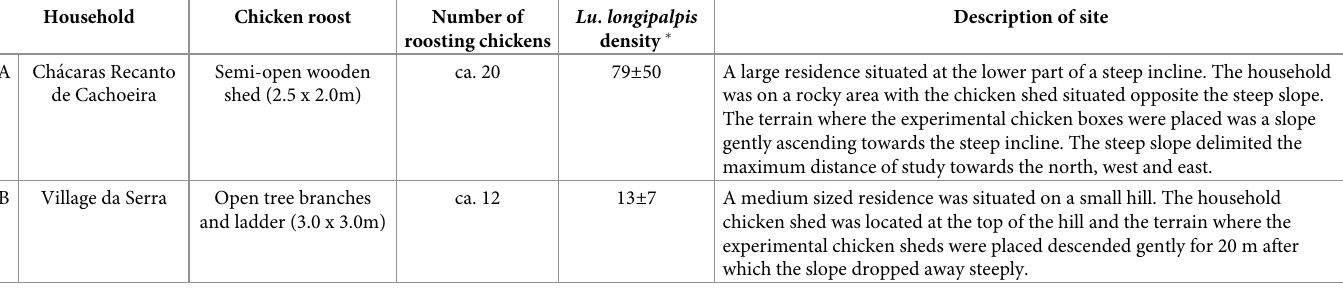
Table 1. Physical characteristics of the household sites where the MRR experiments were carried out in Governador Valadares (Minas Gerais,